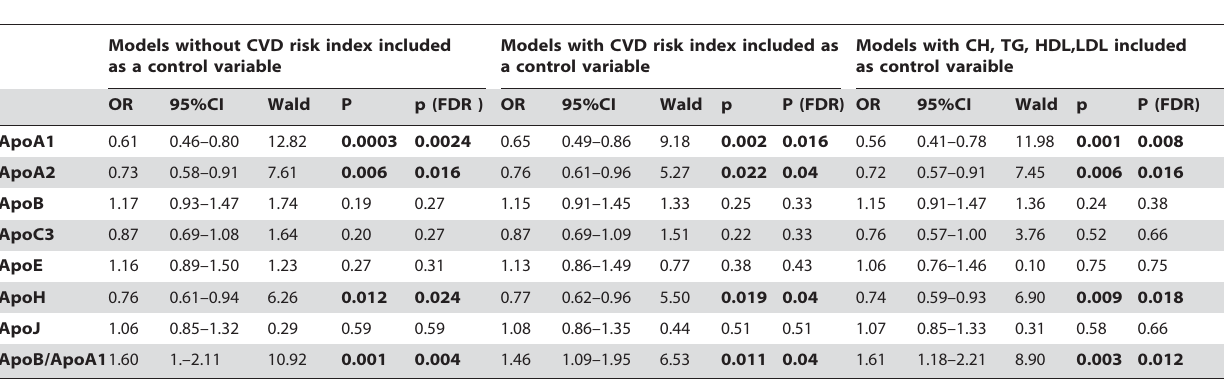
Table 7 . Logistic regression analyses for the prediction of conversion from CDR 0 at Wave 1 to CDR . 0 at Wave 2 from Wave 1 plasma apolipoprotein levels.